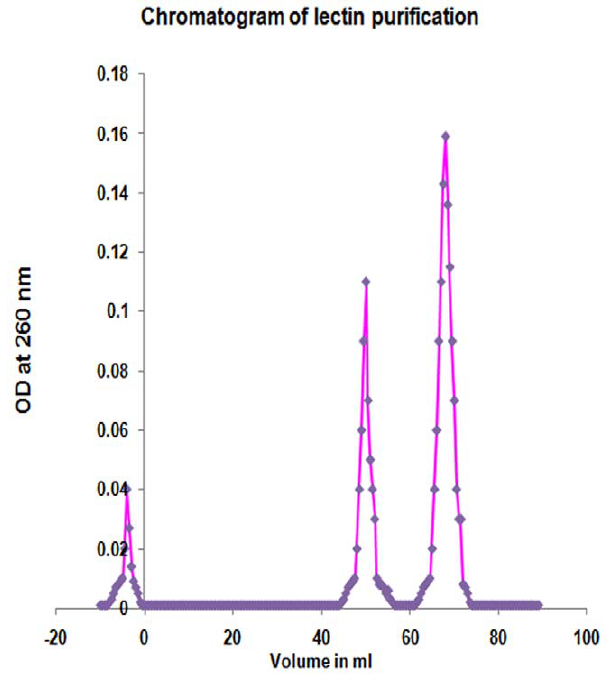
Figure 2. Elution profile of lectin purification. Gel filtration chromatography of 60% ammonium sulphate precipitate of AMFL using Sephadex G – 75 (1.5 cm 6 100 cm) showing two peaks peak I (fractions 46–56 after void volume or 23–28 ml from void volume) and peak II (fractions 59–74 after void volume or 29.5–37 ml from void volume).